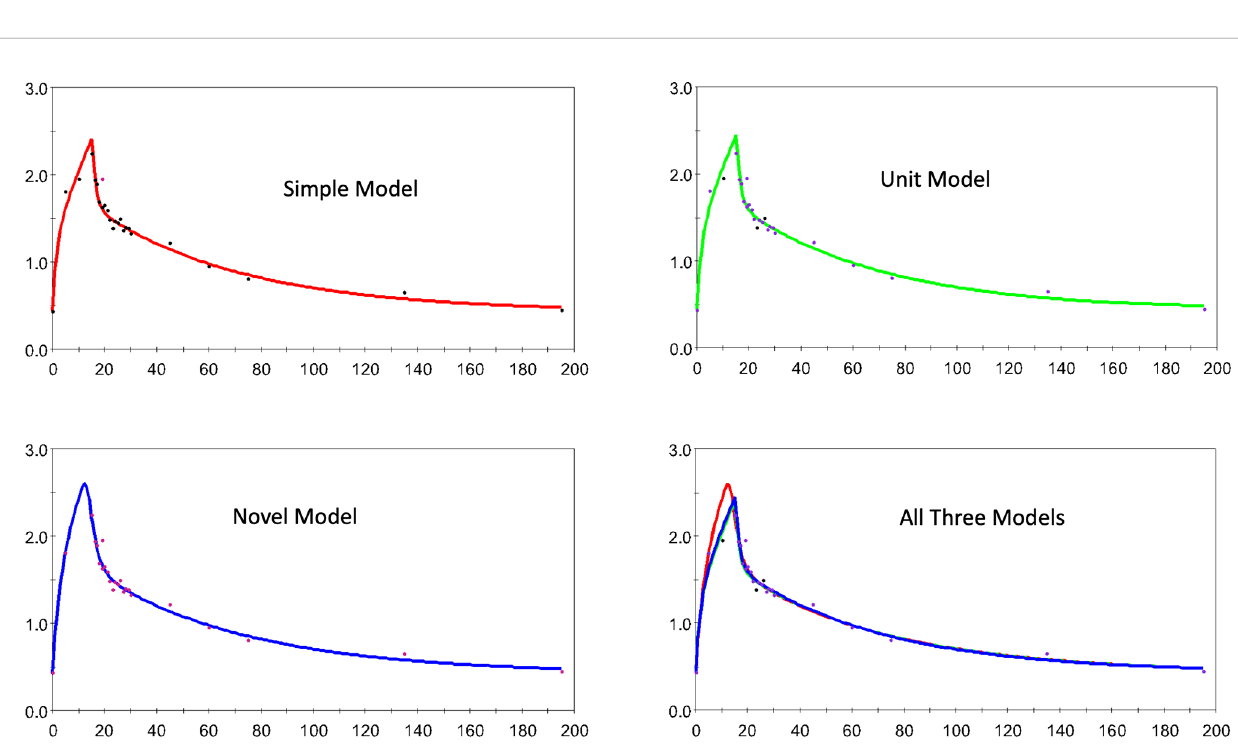
FIGURE 4 | The estimated and observed lactate disposition for the S, U, and N models separately, and all models together are shown for horse 1. Note uniform offset to pre-infusion mean lactate level.